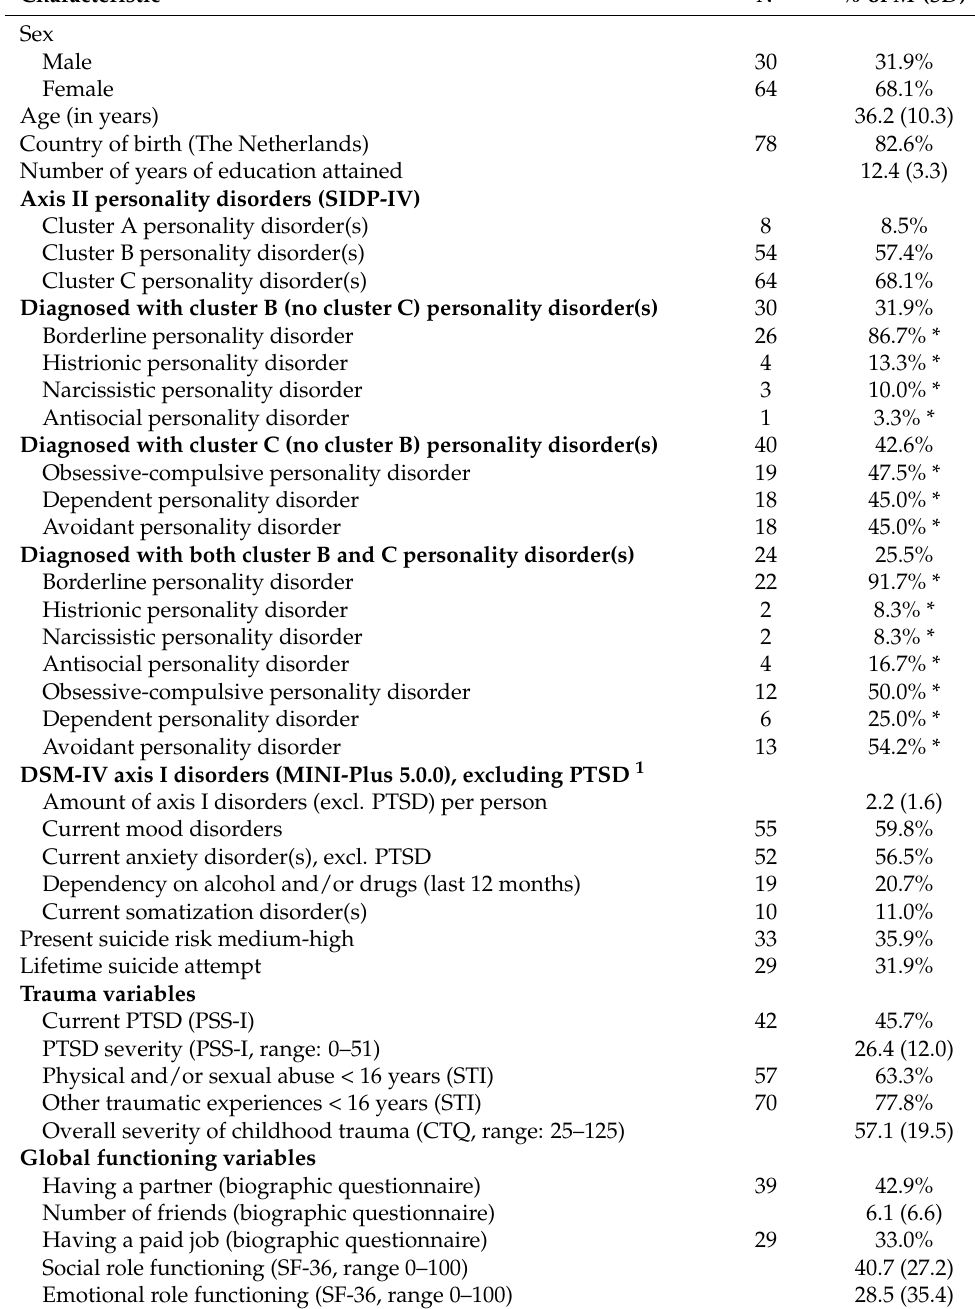
Table 1. Demographics and clinical characteristics of the sample ( N =